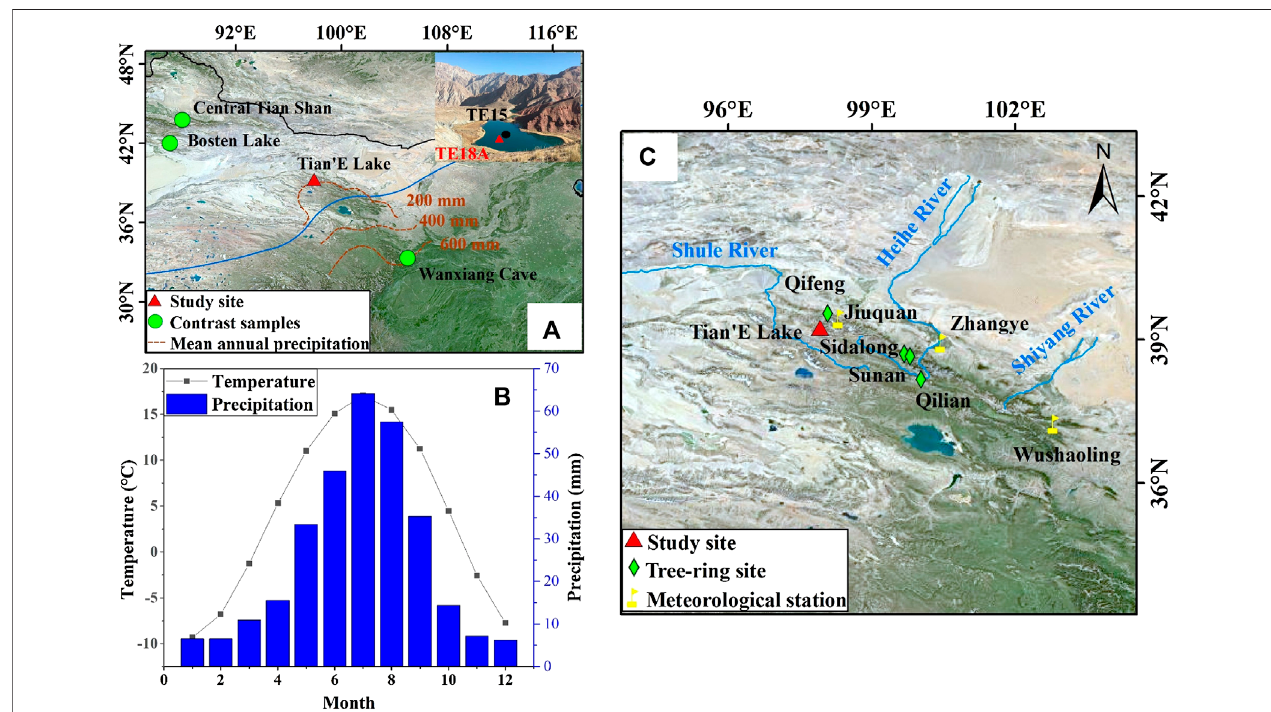
FIGURE1| Locationandenvironmental settingoftheTian ’ ELakearea. (A) LocationofTian ’ ELakeinnorthwesternChinaandlocationsofothersitesmentionedin the text. Inset image is a photo of Tian ’ E Lake showing the location of cores TE18A and TE15. The blue line is the modern limit of the summer monsoon (Chen et al., 2008),andthereddashedlinesdenotethemeanannualprecipitation. (B) MonthlytemperatureandprecipitationattheSunanMeteorologicalStationduring1981 – 2010. (C) Location of Tian ’ E Lake and tree-ring records from the Qilian Mountains referenced in the